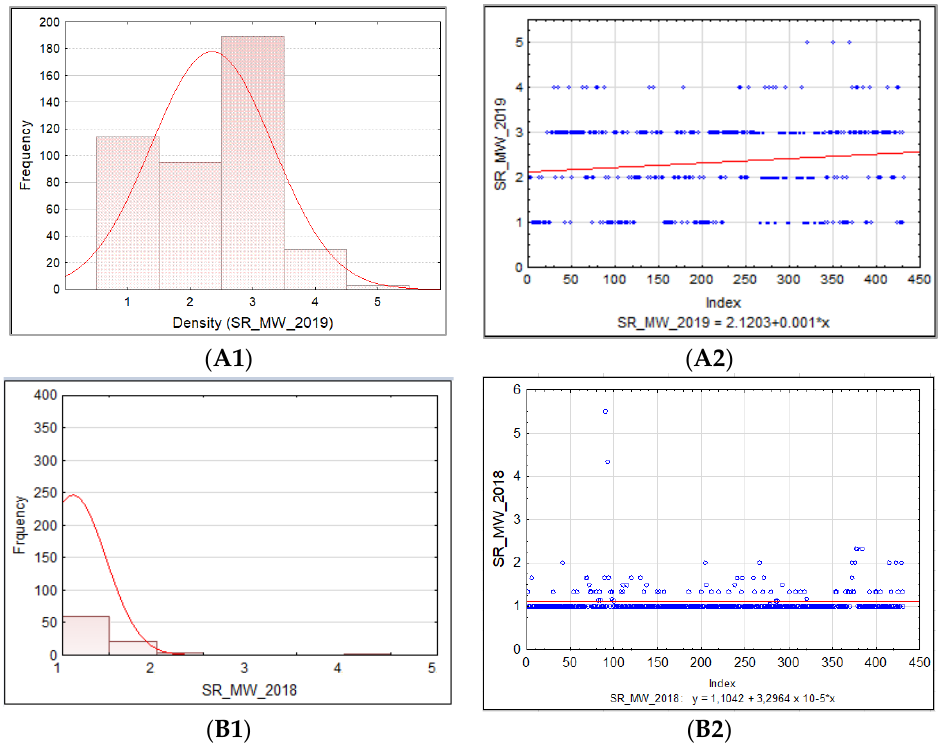
Figure 6. Frequency distribution of the barley accessions for stem rust (SR) resistance scores at milky-wax (MW) stage in 2018 and 2019. Frequency distribution of the barley accessions for SR at MW stage in 2019 ( A1 , A2 ). Frequency distribution of the barley accessions for SR at MW stage in 2018 ( B1 , B2 ). Figures ( A1 , B2 ) present the regression analysis model estimating the relationship between the SR resistance scores and the frequency index. Disease severity was scored on the 1–9 scale (1 = immune reaction).